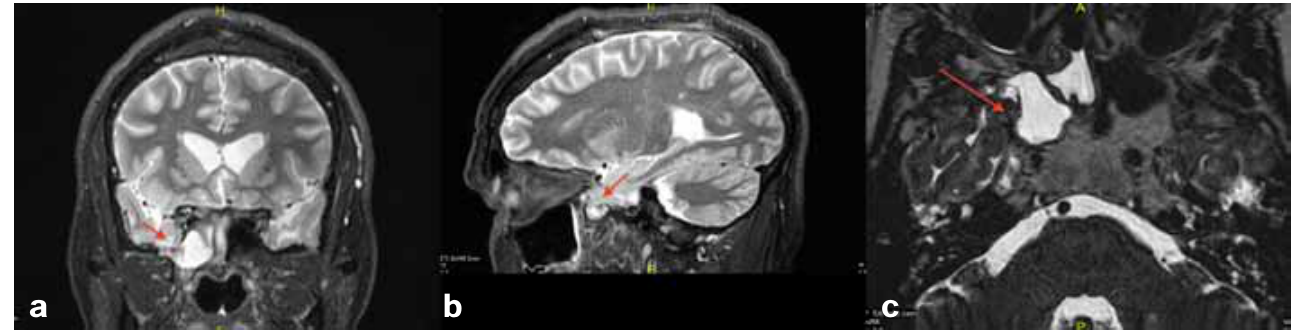
Figs 1a - 1c. MRI scans of the brain and sphenoid sinus in a patient with lateral sphenoidal CSF fistula. (1a) Coronal (1b)sagittal and (1c) high-resolution axial T2-weighted images demonstrate a herniation of CSF-filled meninges from the right middle temporal fossa into the right sphenoid sinus through a bony defect (arrow). There is subtle encephalomalacia of the right temporal